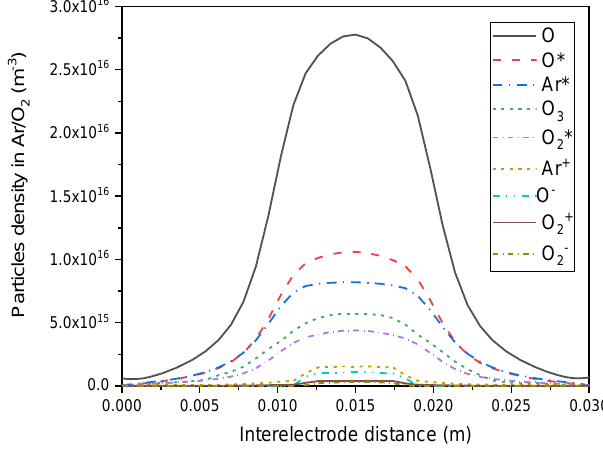
Figure 4. Distribution of different particles density at 0.3 Torr total gas pressure, RF voltage (150 V, 13.56 MHz), and 20% O 2 . (*) Excited state of atoms. The 2D densities distribution of atomic oxygen, excited oxygen atom and ozone, rep- resenting the most important antibacterial agents, and the exited argon atom are illus- trated in Figure 5.